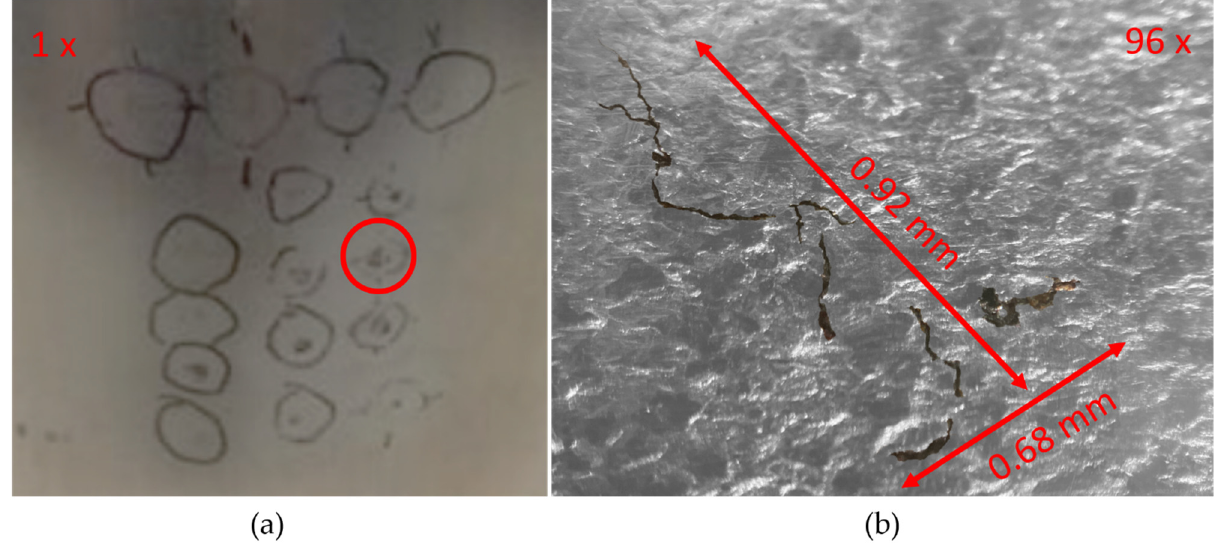
Figure 12. Photo of crack matrix and micrograph ( a ) Photo of crack matrix with the defect of interest highlighted in a red circle. ( b ) Micrograph of the defect of interest at 96 × zoom with desaturated background.